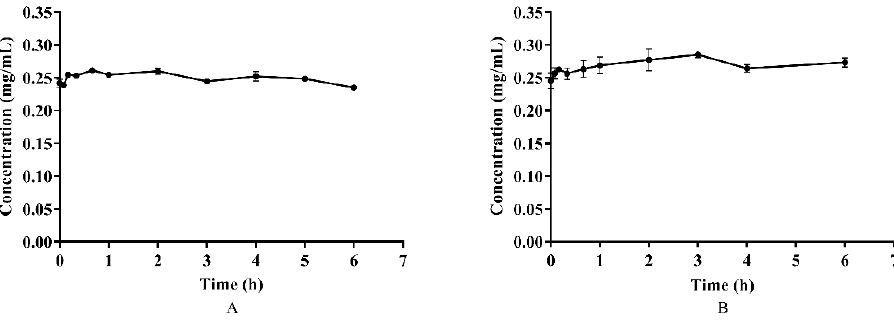
Figure 3. The stability of azalomycin F in plasma ( A ) and whole blood ( B ) ( n = 3) .